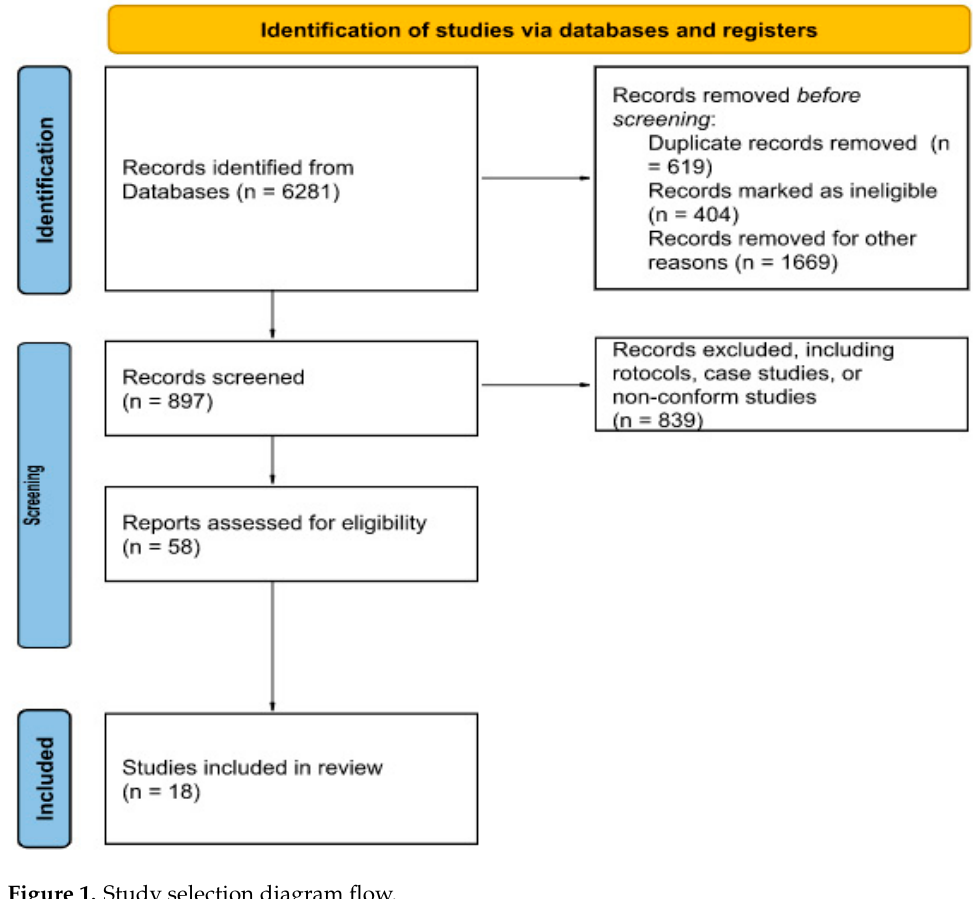
Figure 1. Study selection diagram flow.